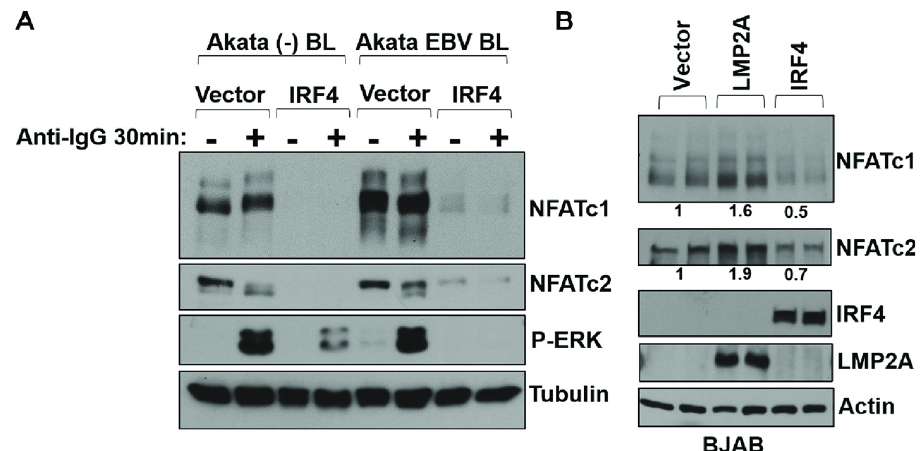
Fig 10. IRF4 inhibits NFATc1 and NFATc2 expression. (A) EBV positive or negative Akata BLs stably infected with pLKO (vector control) or IRF4 lentiviruses were treated with or without anti-IgG for 30 minutes and then harvested for immunoblot to detect expression of NFATc1, NFATc2, phospho-ERK, and tubulin loading control as indicated. (B ) EBV-negative BJAB B cells were nucleofected with vector control, an LMP2A expression vector or an IRF4 expression vector as indicated then harvested after 48 hours for immunoblot analysis of the NFATc1, NFATc2, IRF4, LMP2A, and actin proteins. The numbers below the NFATc1 and NFATc2 immunoblots quantify the results using Image Studio Lite software to normalize the levels of NFATc1 and NFATc2 expression to actin expression. Results are presented as the ratio of NFATc1 and NFATc2 expression relative to actin for each condition, then averaged for each duplicate, and divided by the vector control values. Vector control values are set as